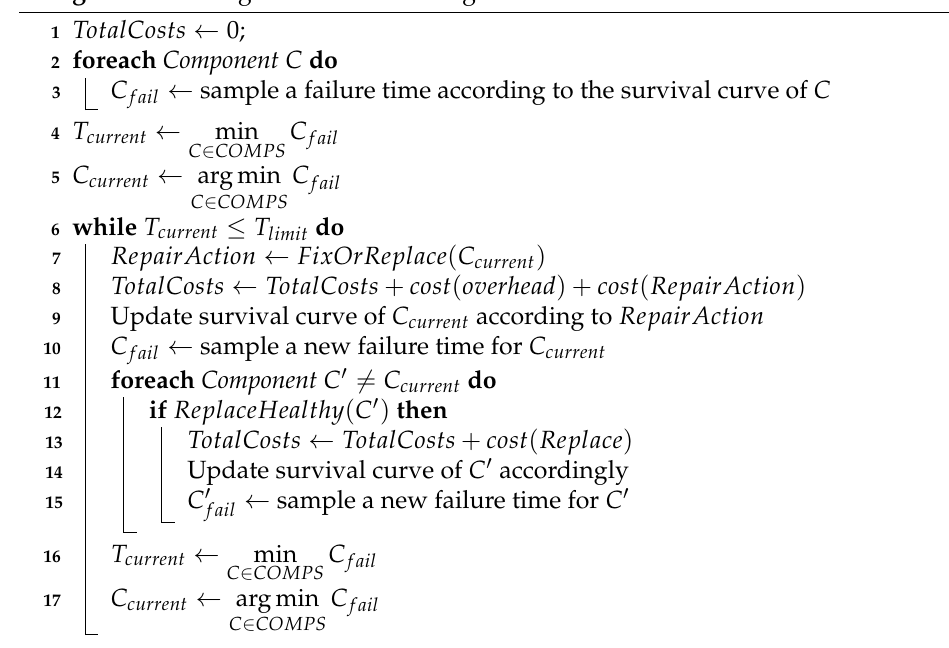
Algorithm 2: Long-term simulation